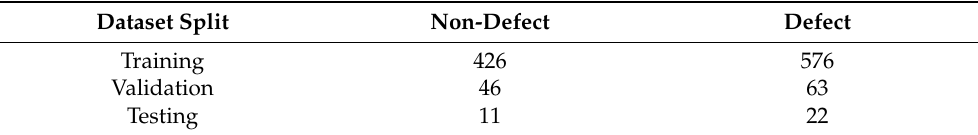
Table 1. Dataset split for training, validating and testing the defect/non defect classifier.